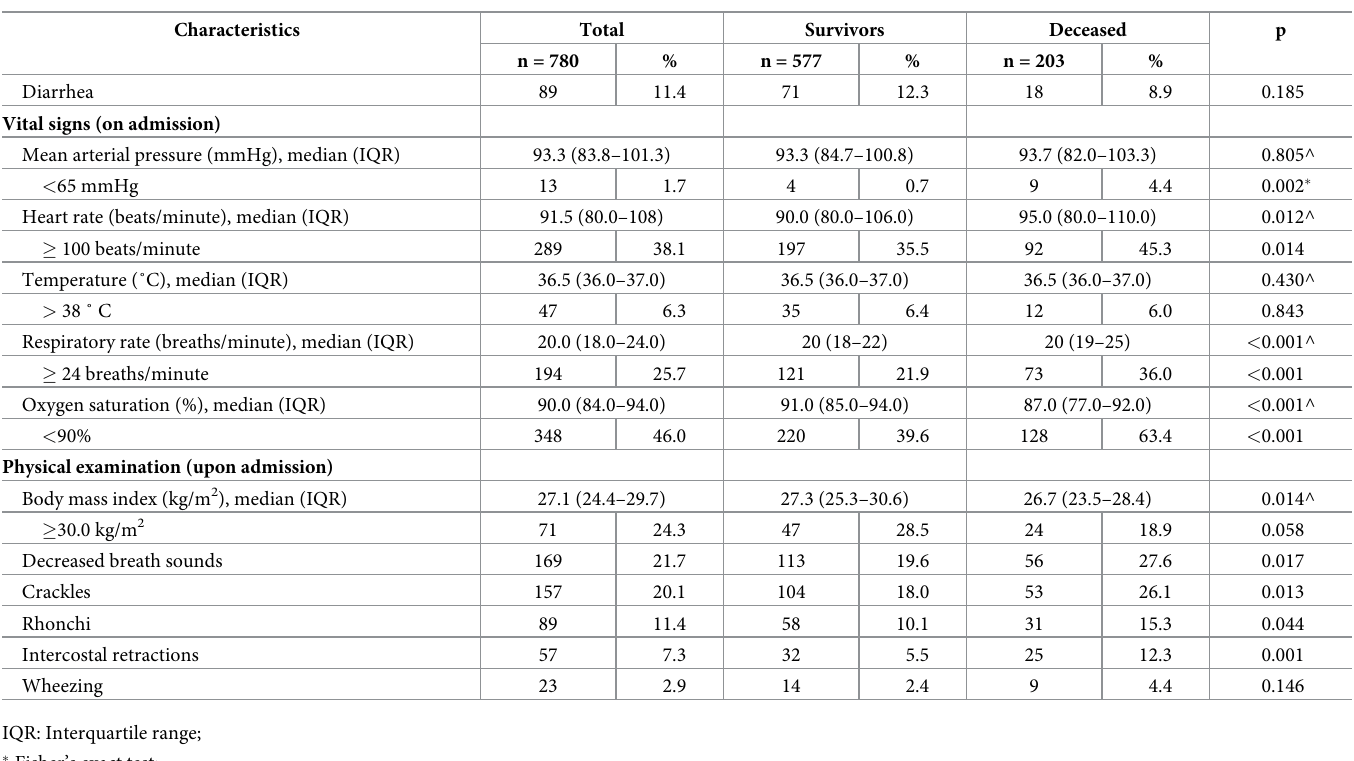
Chest X-rays taken at admission showed abnormalities in 50.3% (n = 392) of patients, with infiltrates being the most frequent finding (n = 287; 36.8%); the predominant feature in CT scans was ground-glass opacity (n = 364; 46.7%). Table 2 describes the radiological and labora- tory